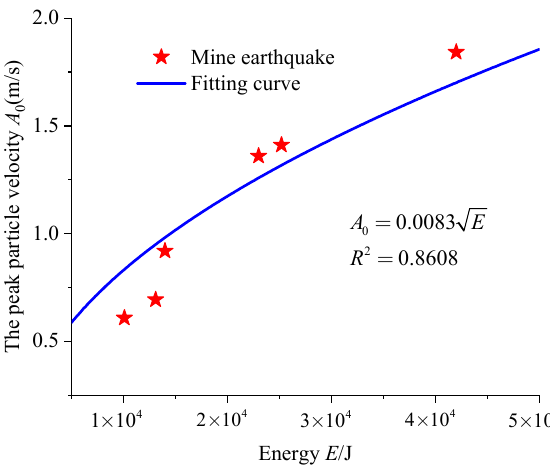
Figure 9. Mine earthquake amplitude and energy relation fitting.